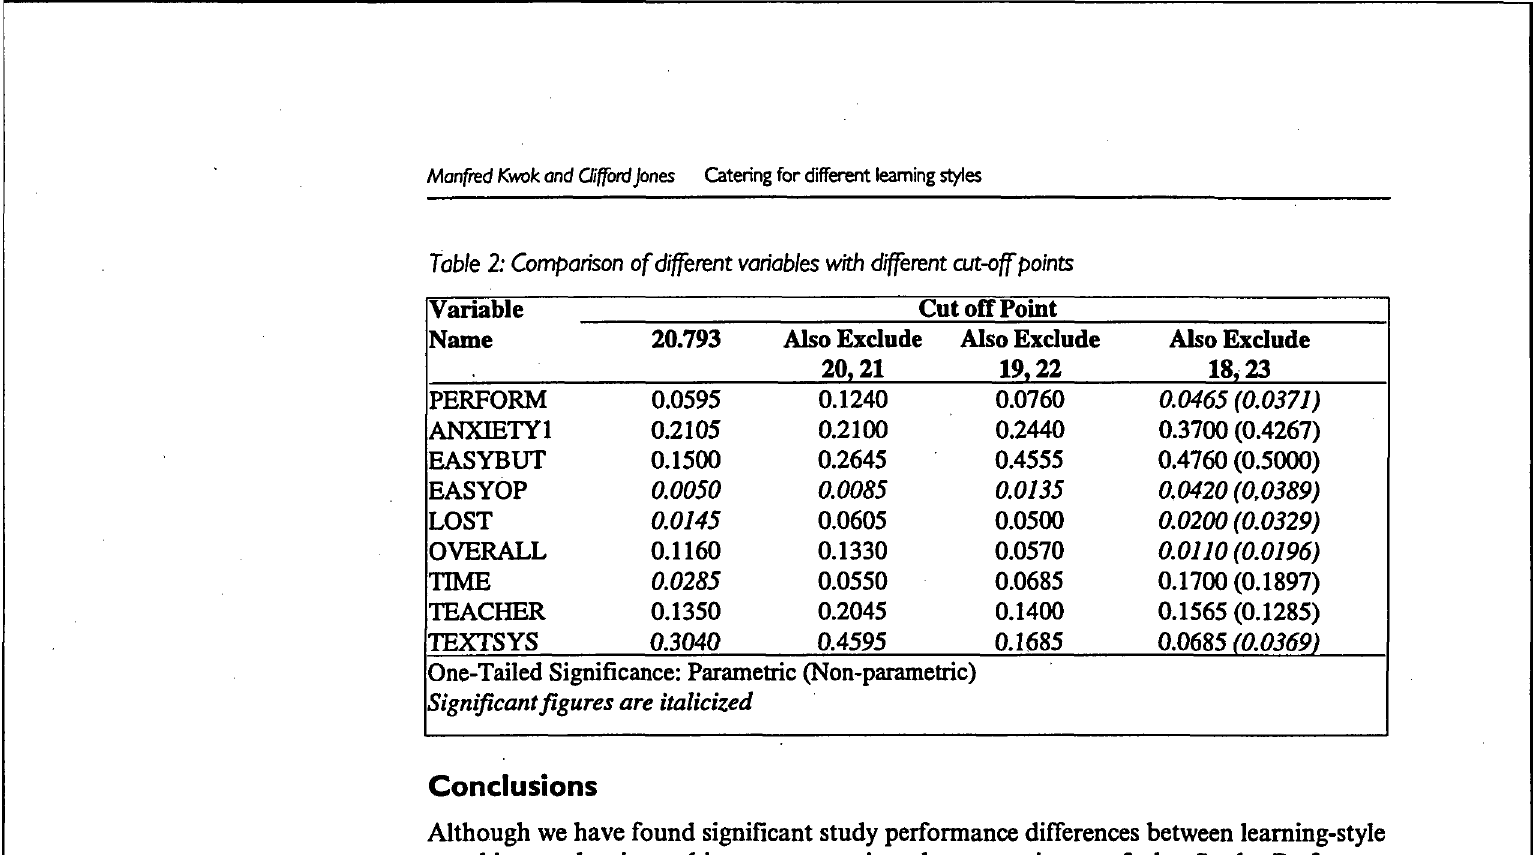
Table 2: Comparison of different variables with different cut-off points